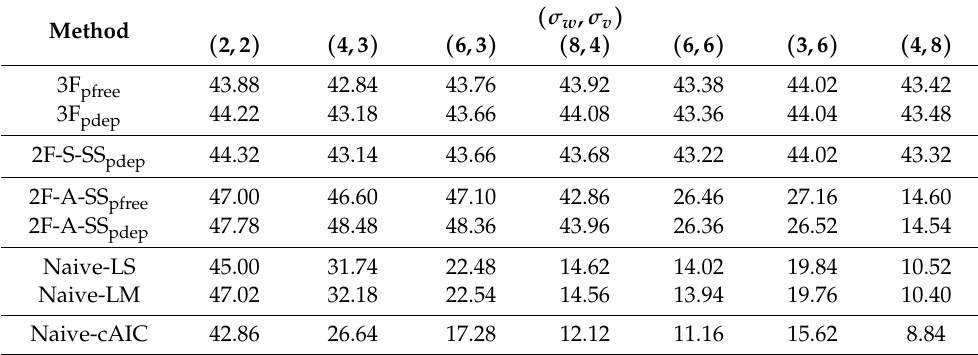
Table 2. True model selection rate (%): AIC and